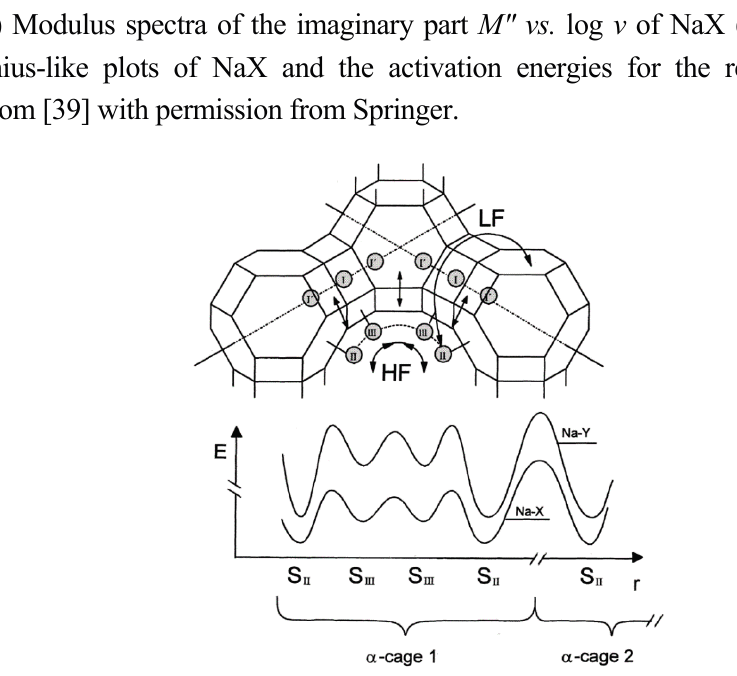
Figure 3. Illustration of the conductivity processes in Faujasite zeolite and the corresponding potential profile indicating the different activation energies of the high-frequency and low-frequency processes [39]. Reprinted with permission from